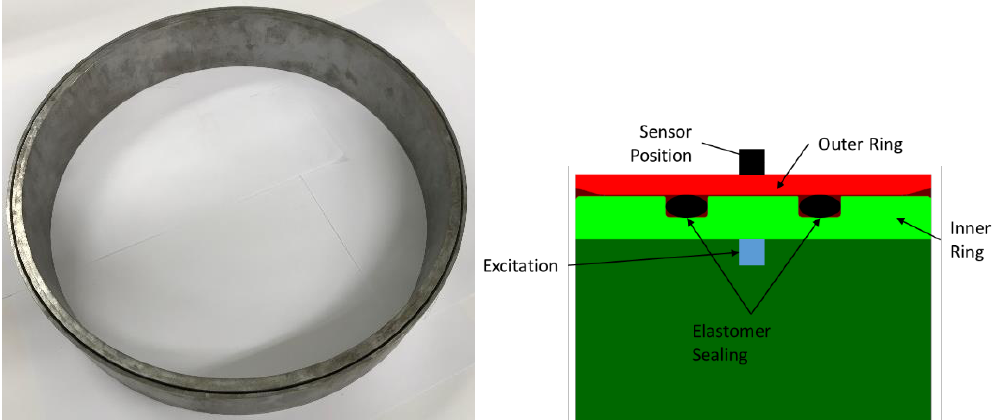
Figure 2. Assembly of the fixture in reality ( left ) and sectional view of the fixture ( right ).